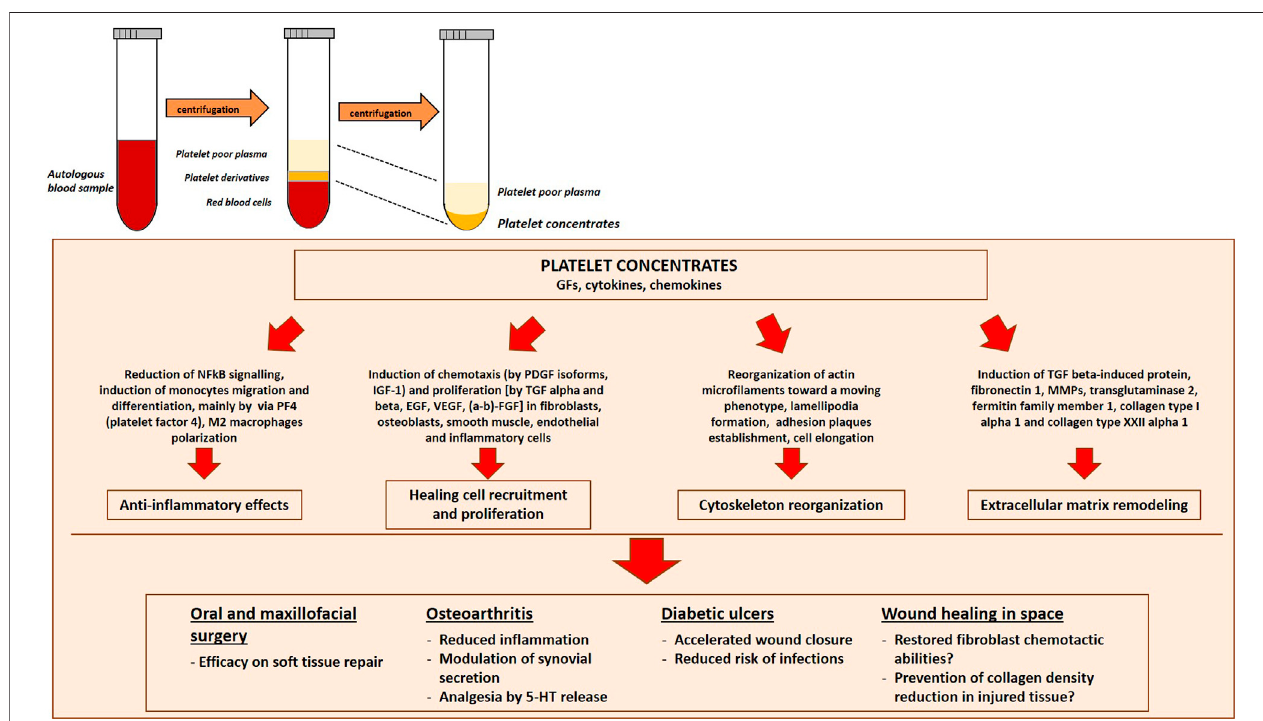
FIGURE4| PlateletRichPlasma(PRP) preparation andef fi cacyindifferentclinicalconditions.PRPispreparedbycentrifugation ofperipheralbloodtoconcentrate platelets. Platelet derivatives are promising tools to promote regeneration and healing for future space travel. Indeed, they have yielded excellent results in different medical fi elds,fromoralandmaxillofacialsurgicalprocedures,tothetreatmentofsymptomaticosteoarthritispatientsanddiabeticulcers.NF κ B,NuclearFactorkappaB; TGF- β , Transforming Growth Factor β MMPs, Matrix Metallo-Proteinases, 5-HT, serotonin.